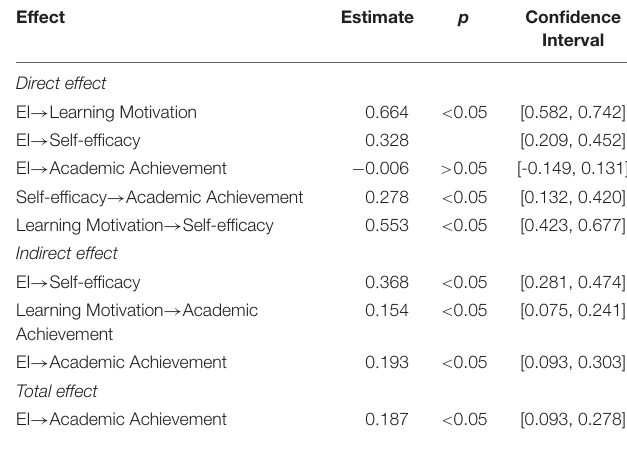
TABLE 3 | Bootstrap SEM analysis of total, direct, and indirect